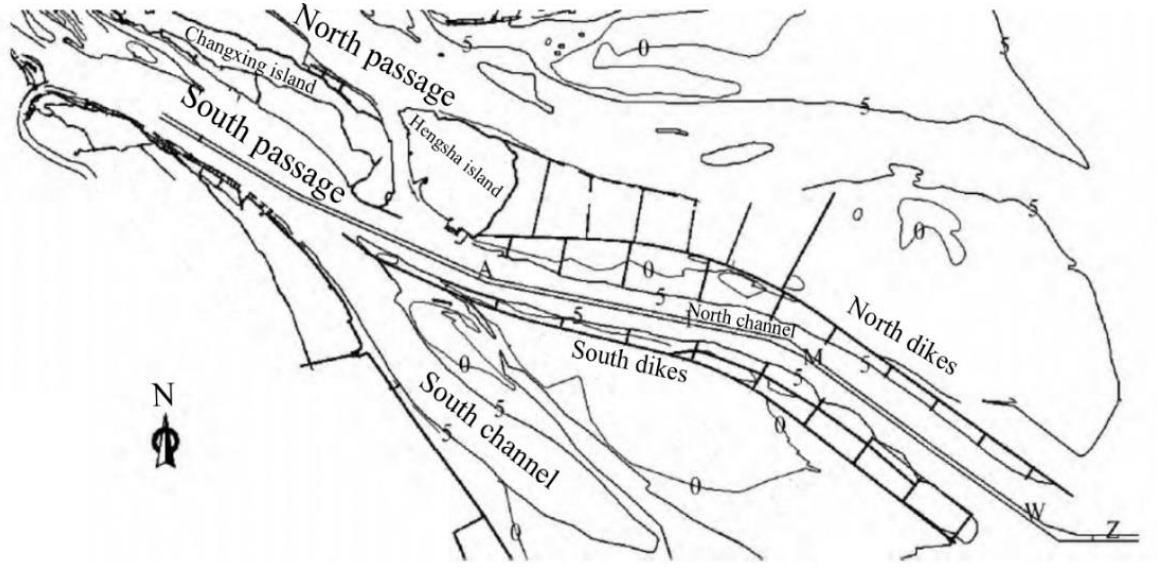
Figure 6. Layout of regulating structure in the North Passage.